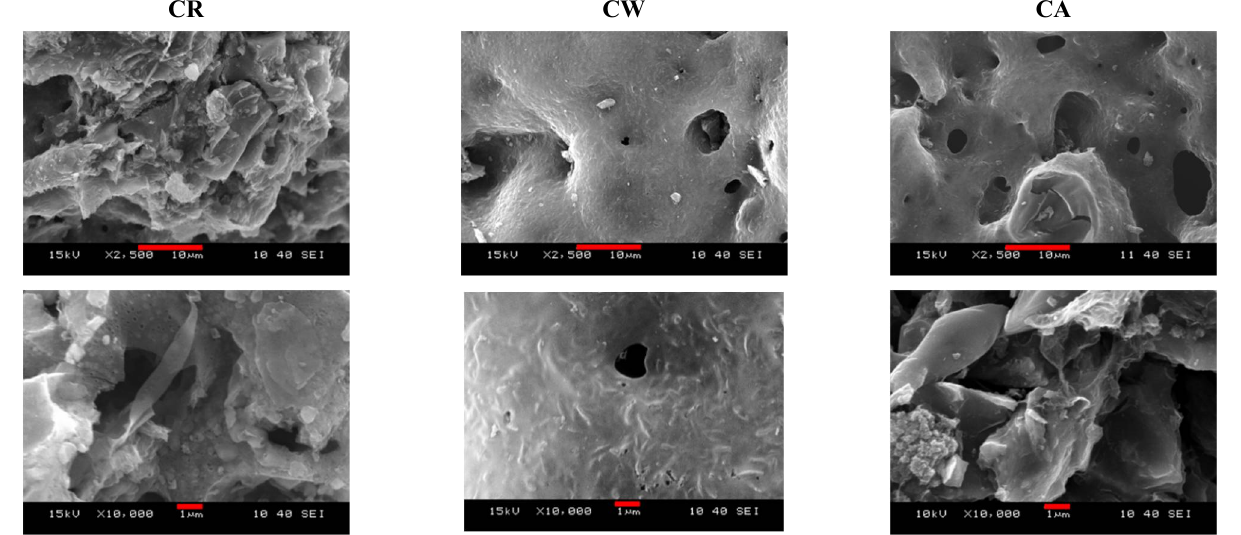
Figure 3. SEM images of carbon aerogel samples CR, CW, and CA. The scale bars are 10 and 1 µm in the upper and lower raw, respectively.